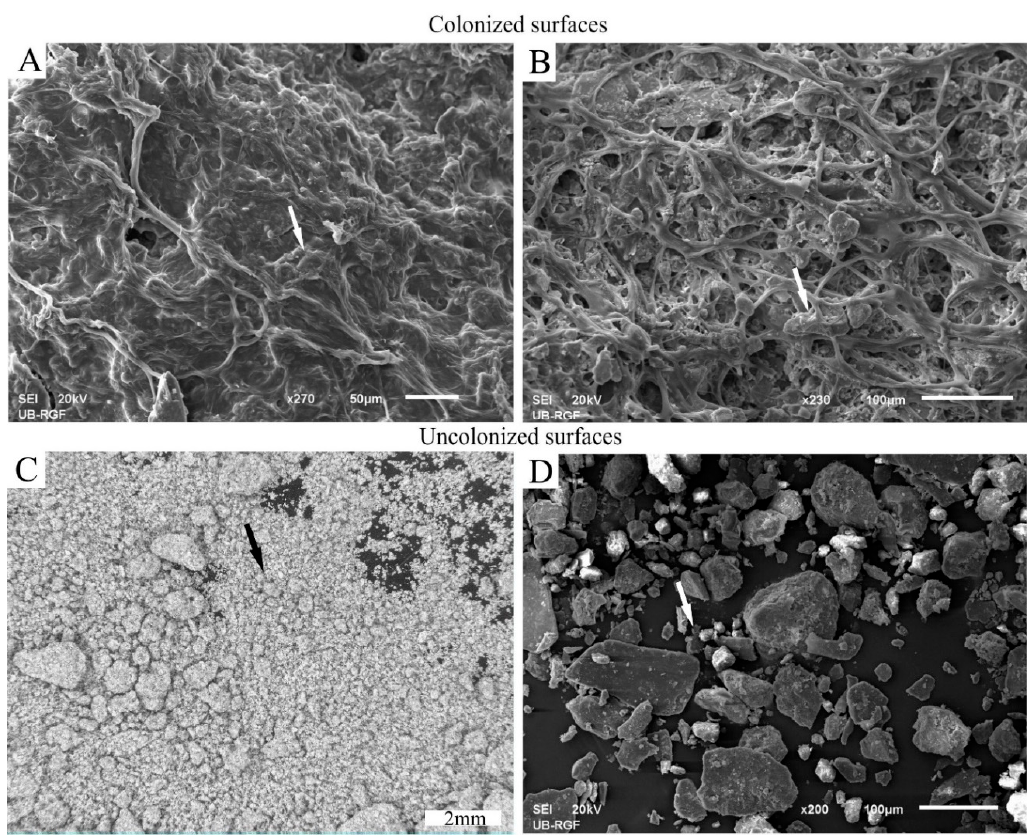
Figure 6. Difference between colonized and uncolonized surfaces of experimental chamber ( A , B ) and control chamber ( C , D ), respectively. The scanning electron microscopy (SEM) micrographs show a cyanobacterial carpet-like structure ( A ) and a cyanobacterial network ( B ) adhering the airborne dust particles in the experimental chamber (arrows); the stereomicroscopic image ( C ) and the SEM micrograph ( D ) show loosely aggregated dust particles in the control chamber (arrows).